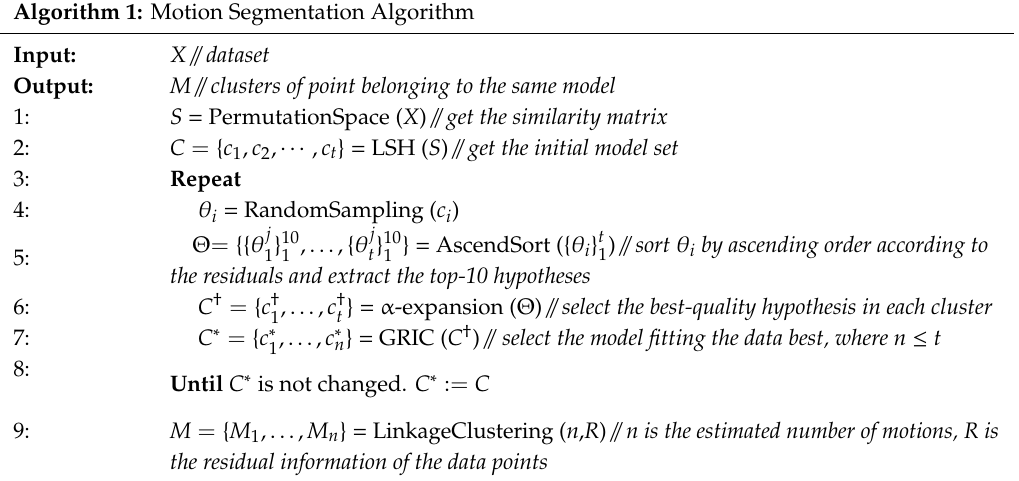
Algorithm 1: Motion Segmentation